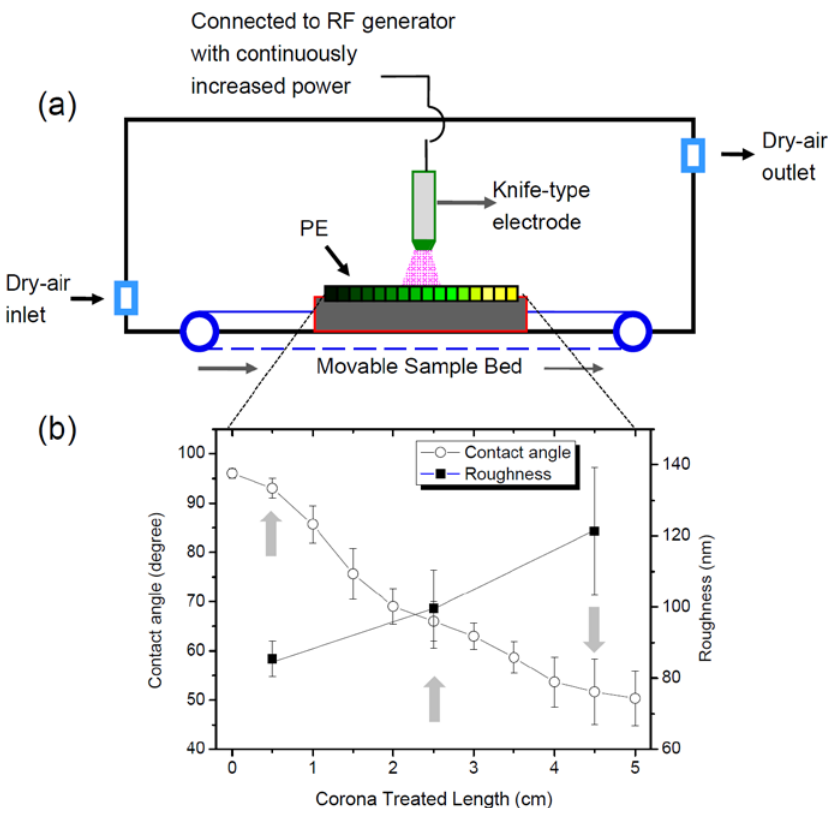
Figure 1. ( a ) Schematic diagram of the corona discharge apparatus used to prepare gradient surfaces; and ( b ) water contact angle versus corona-treated polyethylene (PE) length. RF, radio